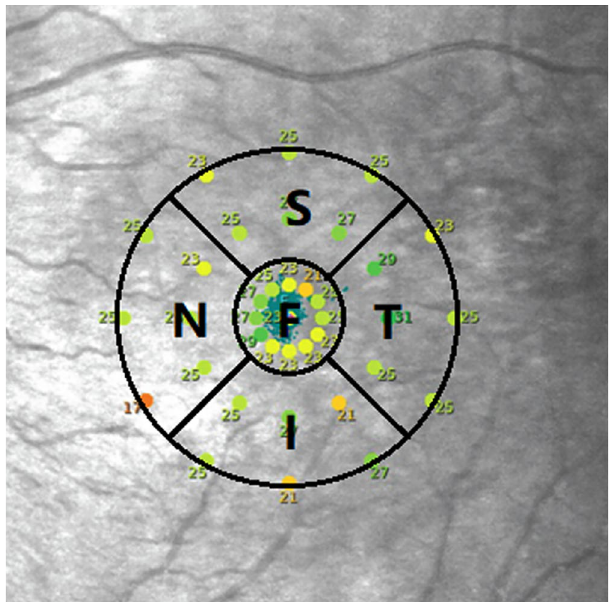
Figure 4. Division diagram of the fixation location based on microperimetry examination results. The inner circle and outer circle represent the 2° and 10° fixation ranges of the macular area respectively. The lines between the two circles are ± 45° with the horizontal line. Fixation locations beyond the foveola were divided into superior, inferior, nasal and temporal fixation